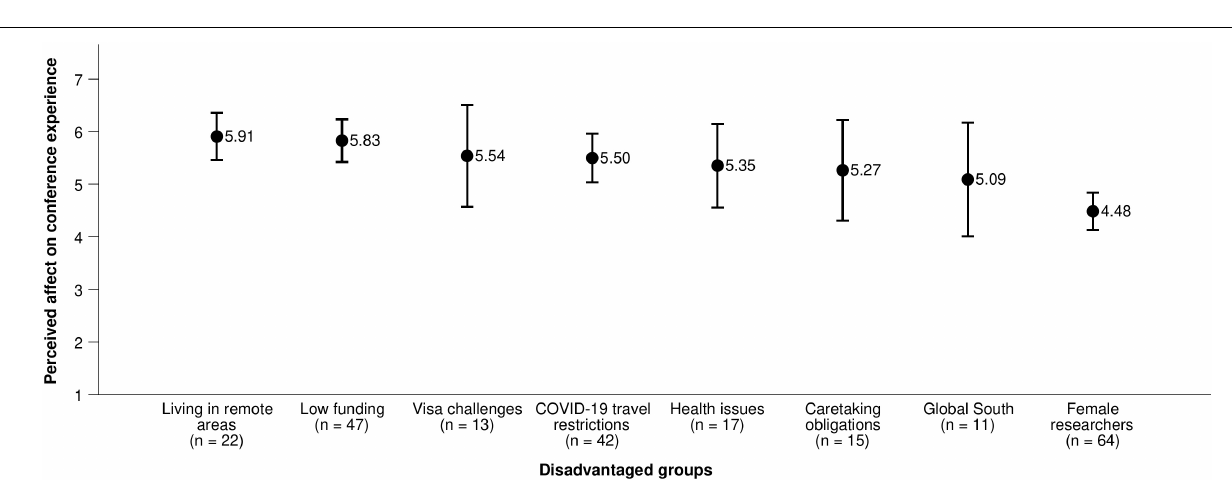
FIGURE 2 | How a hybrid conference format would affect the conference experience of participants’ groups. Variables were measured on a scale from 1 (it would make their experience much worse) and 7 (it would make their experience much better). Error bars represent 95% confidence